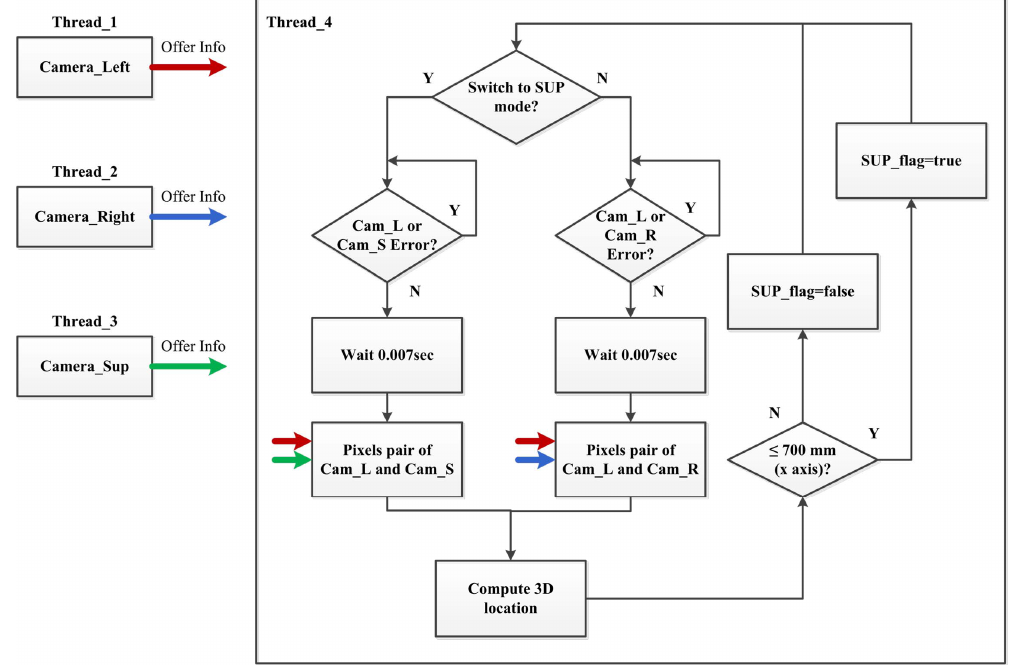
Figure 4. Control of the